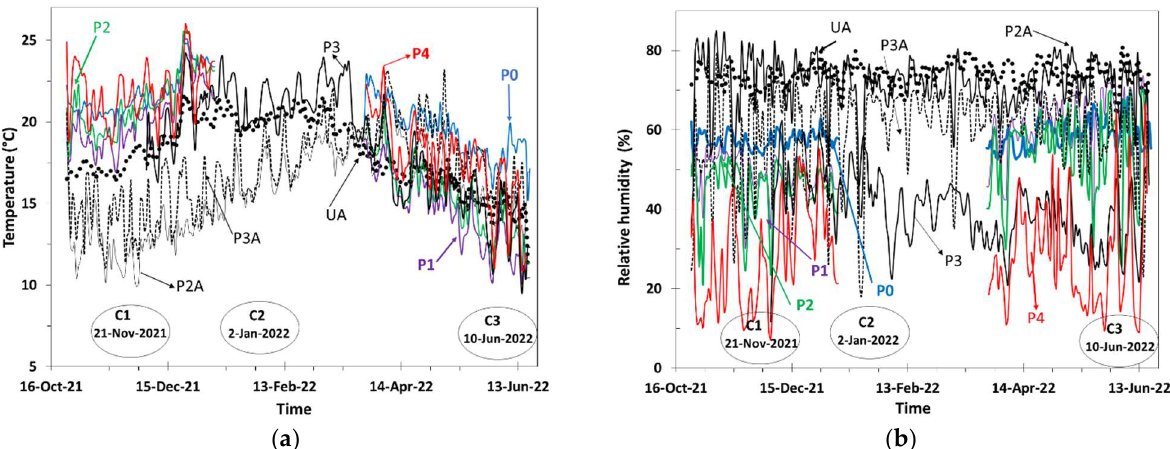
Figure 5. Daily average temperature ( a ) and relative humidity ( b ) values from 24 October 2021 to 18 June 2022, measurements by ground-level sensors.